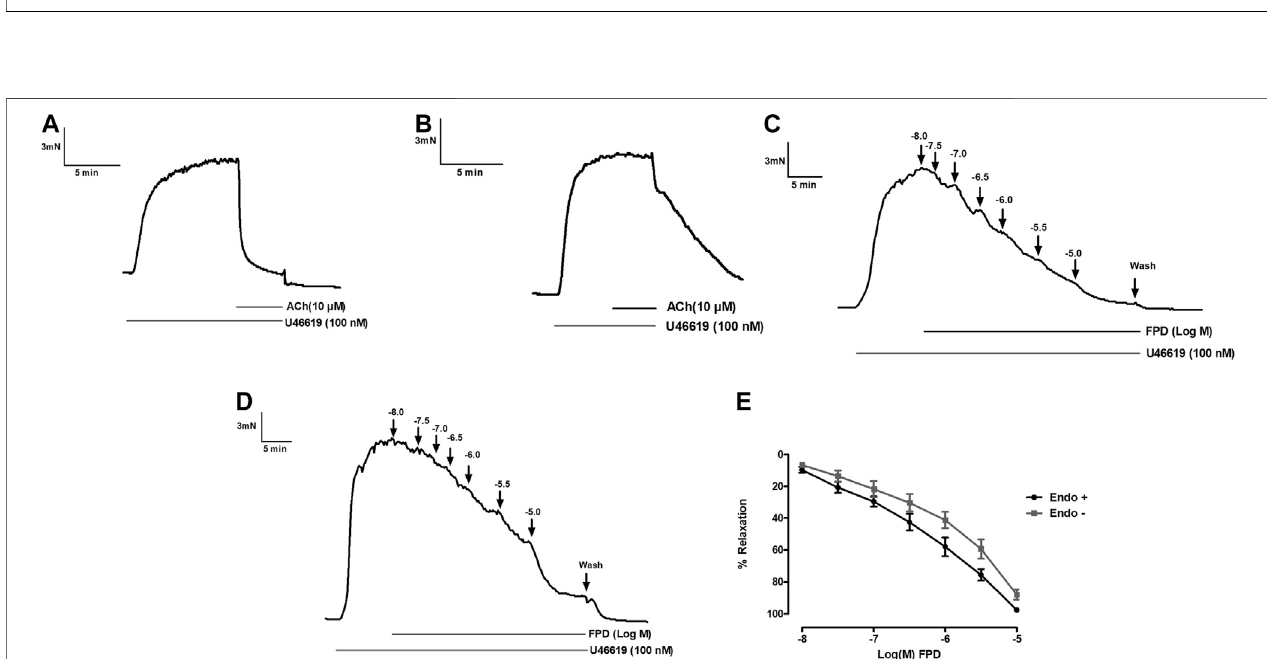
FIGURE 3 | Traces showing acetylcholine (10 µM)-induced relaxation in endothelium-intact (A) and endothelium-denuded (B) isolated rat superior mesenteric arterial rings pre-constricted with U46619 (100 nM). Traces showing FPD-induced concentration dependent relaxation in endothelium-intact (C) and endothelium- denuded (D) arterialringspre-constrictedwithU46619(100 nM).Eshowsthesigmoidalconcentrationresponsecurveobtainedin (C,D) .Relaxationisexpressedasthe mean ± S.E.M. ( n (cid:2) 8) percentage reversal of U46619-induced contraction.